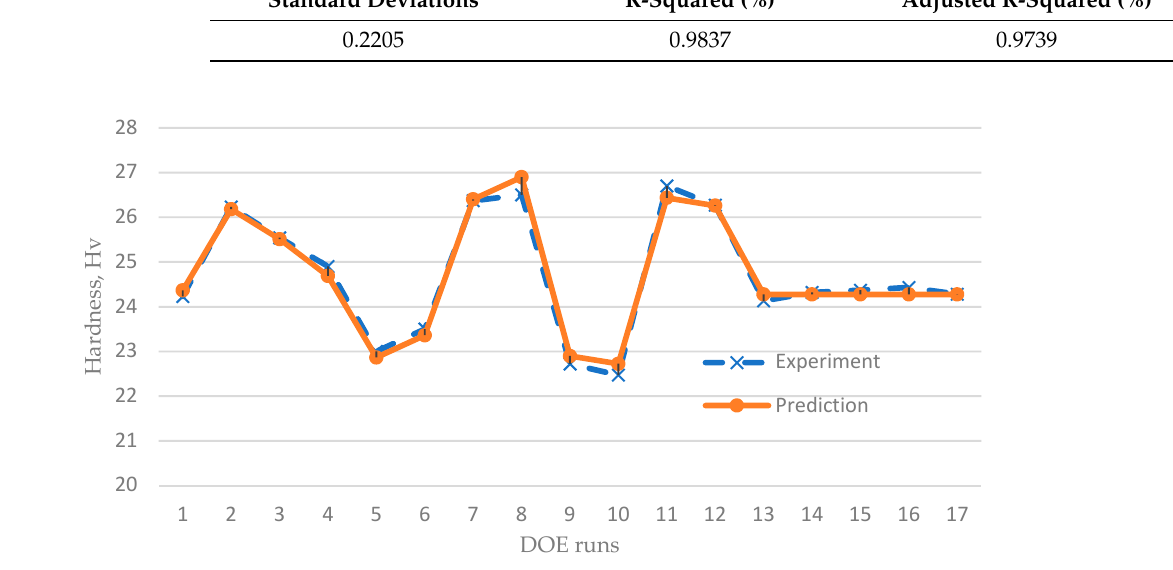
Figure 10. Experiment versus prediction results.